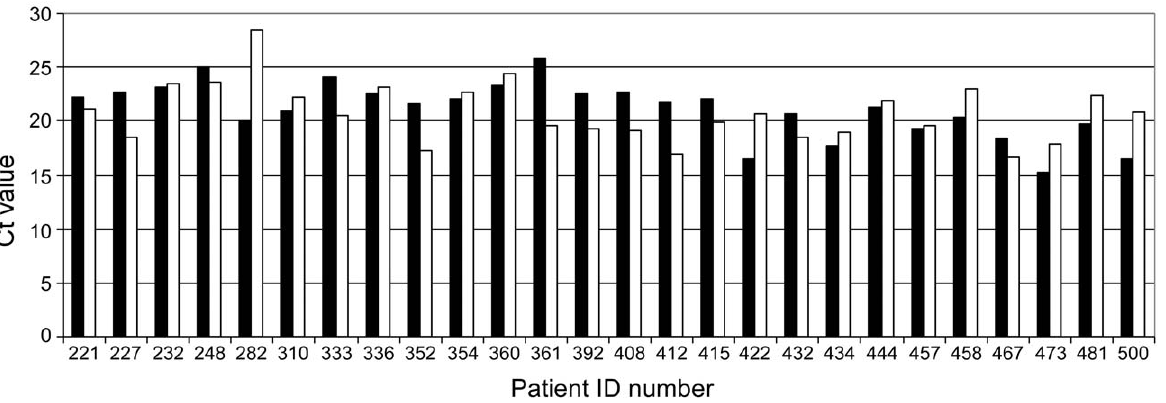
Figure 5. Cycle threshold values for paired blood and swab samples. Cases where whole blood ( & ) and swab ( % ) samples were available for testing the same day are shown. Viral loads from both sample sources were comparable and do not consistently indicate one sample source as more suitable for viral load determination.